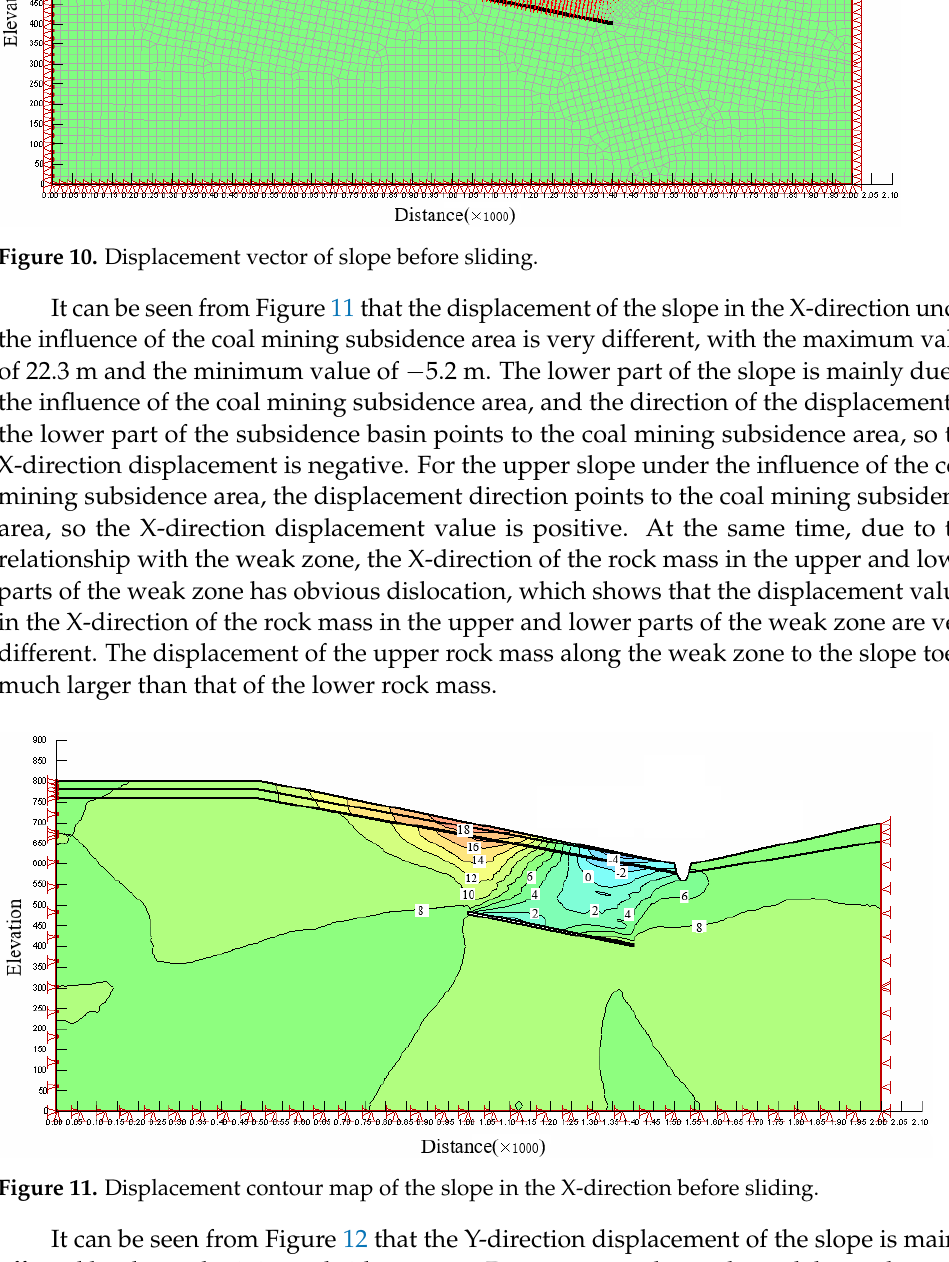
15 of 27 Figure 9. Iterative 607,693-step numerical simulation results. 4.2.2. Finite Element Numerical Simulation Results (1) Displacement analysis In Figure 10, the green part is the model grid, and the size and direction of the red arrow represents the displacement vector of the grid node. It can be seen from Figure 10 that the displacement of the slope mainly occurs in the middle and lower part of the slope and above the coal mining subsidence area. Due to the influence of mining, the stress field of the rock mass above the coal mining subsidence area is changed, and the stress of the rock mass in the mining area is released. The rock mass moves downward under self- weight stress and the extrusion of overlying strata, and the coal mining subsidence area